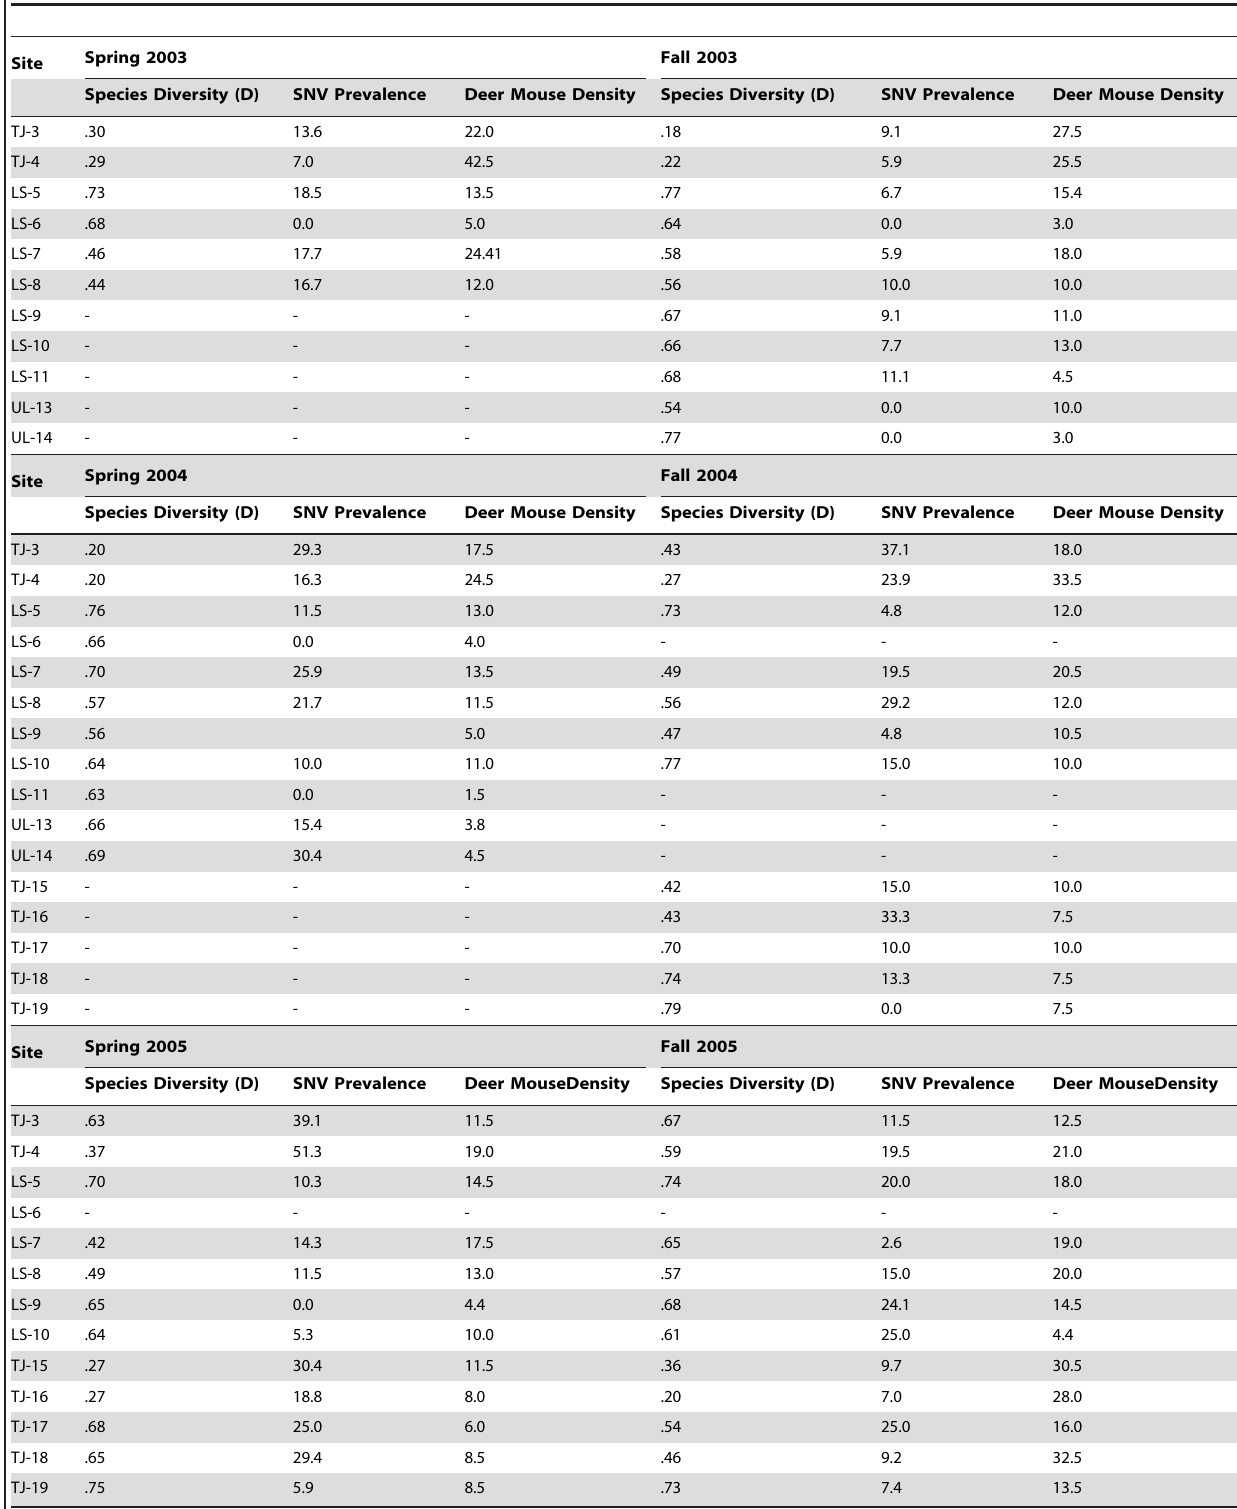
Table 1. Summary of species diversity, prevalence of Sin Nombre virus and density of deer mice (Peromyscus maniculatus) at 16 sites in central Utah sampled